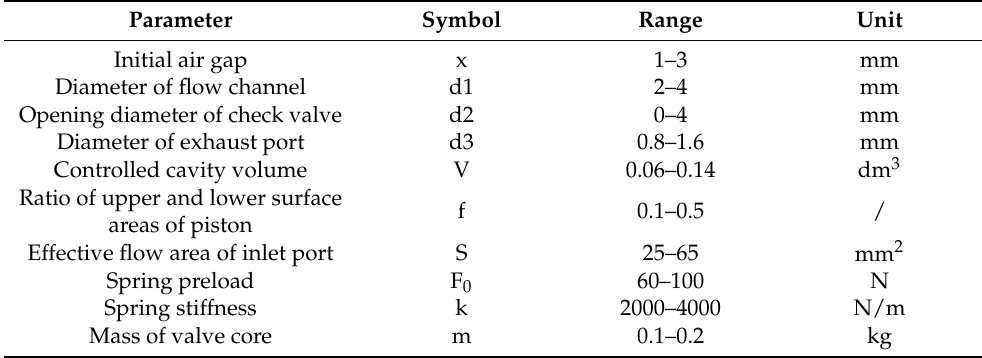
Table 3. Range of Structural Parameters.